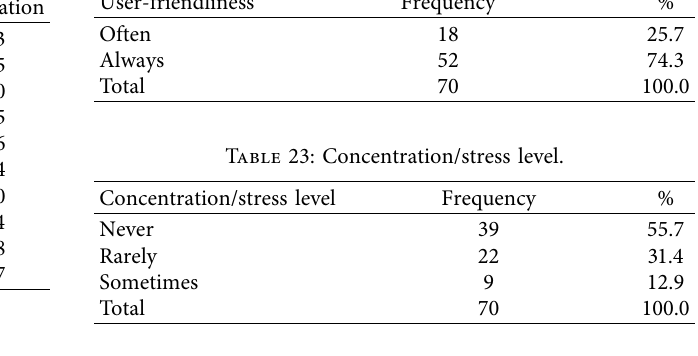
Table 24: Safety.